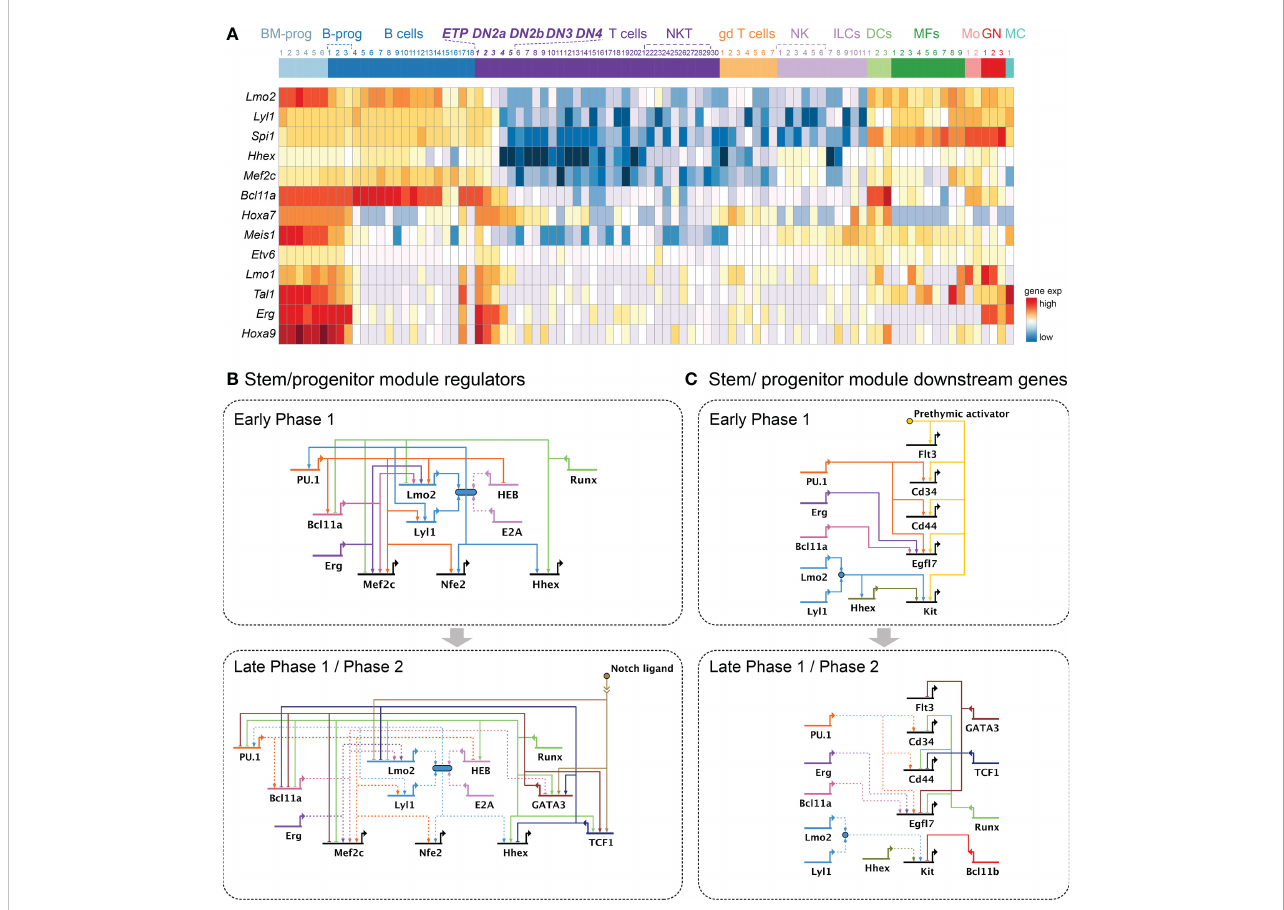
FIGURE 4 Gene regulatory networks controlling the stem or progenitor module. (A) Heatmap illustrates expression patterns of important transcription factors involved in the stem or progenitor module. Heatmap includes the same immune cell populations as Figure 2A. (B, C). Gene regulatory network models as in Figure 2. (B) Current model for key transcription factors shaping the stem or progenitor module in Phase 1 (top) and Phase 2 (bottom). (C) Current model for the stem or progenitor module downstream molecules in Phase 1 (top) and Phase 2 (bottom). Growth factor receptors: Flt3, Kit ; Growth factor molecule: Eg fl 7 ; ETP marker genes: Cd34, Cd44